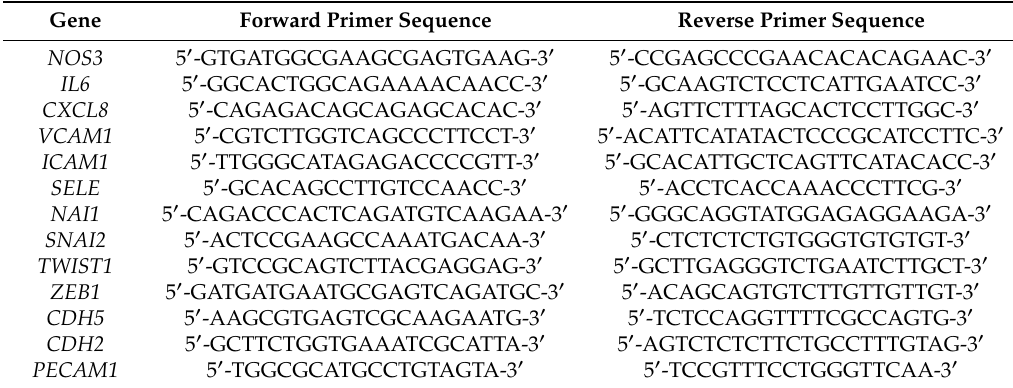
Table 1. Sequences of customised primers for